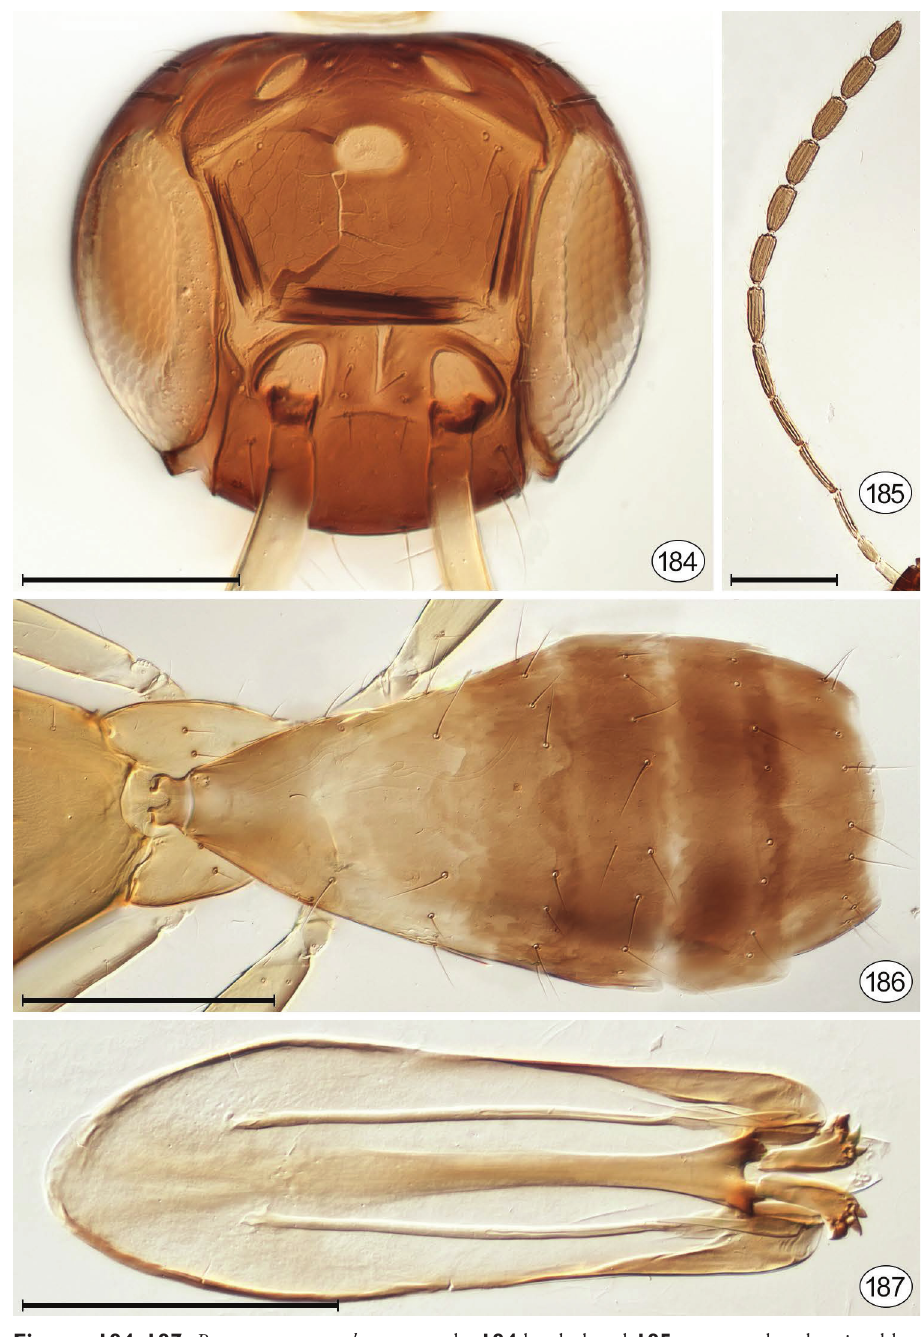
Figures 184–187. Borneomymar madagascar , male. 184 head, dorsal 185 antenna, dorsal, twisted lat- 186 metasoma (gt erally after fl missing) 187 genitalia, dorsal. Scale bar for 184, 187 = 100 μm; 4 7 185, 186 = 200